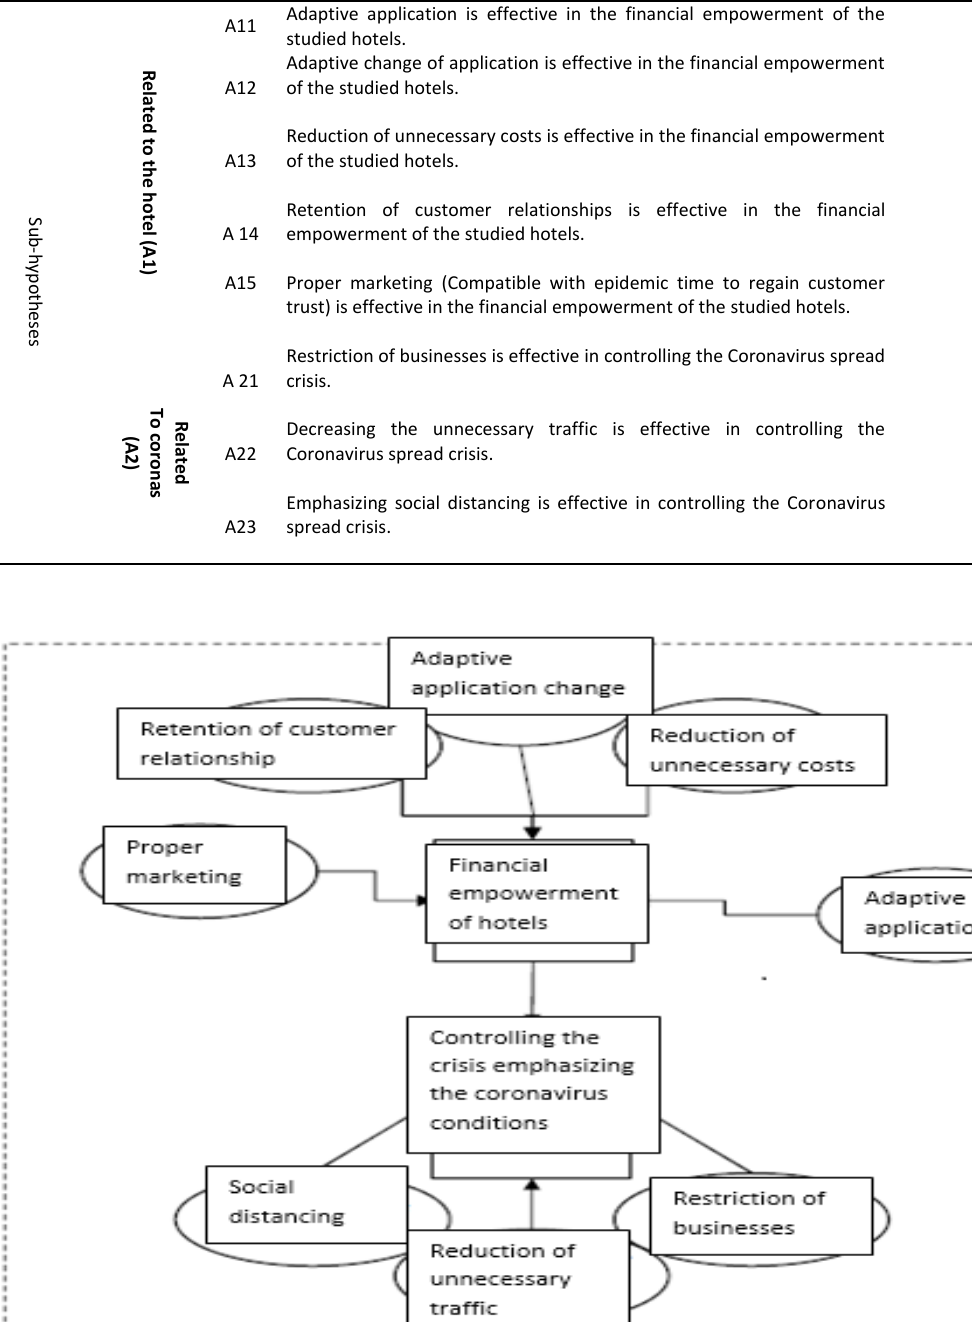
Main Hypothesis: Controlling the Coronavirus spread is effective in the financial empowerment of the studied hotels.